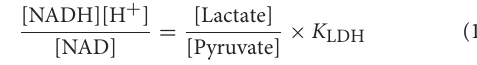
to CO 2 and H 2 O with a net yield of another 36 ATP.